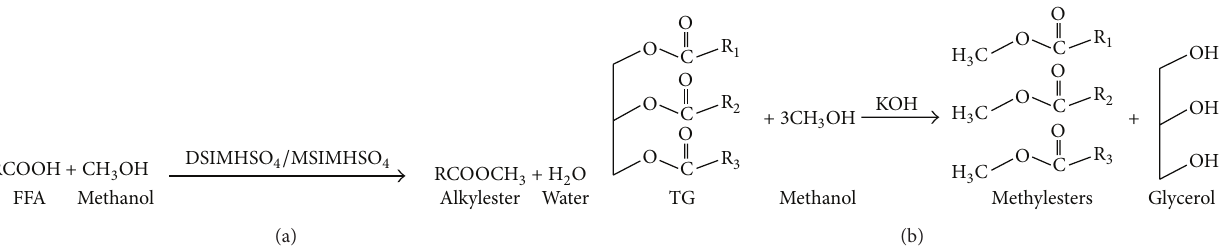
Figure 1: Preparation of CCOME via two-step catalyzed scheme. (a) Esterification of FFA with methanol to form alkyl ester and water; (b) transesterification reaction of TG with methanol to form methyl esters and glycerol. R 1 , R 2 , and R 3 are alkyl groups.